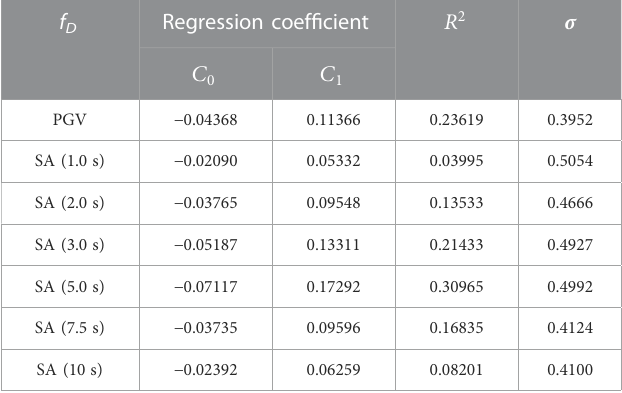
TABLE 3 Summary of regression results for the directivity effect based on the proposed log-linear model. f D Regression coef